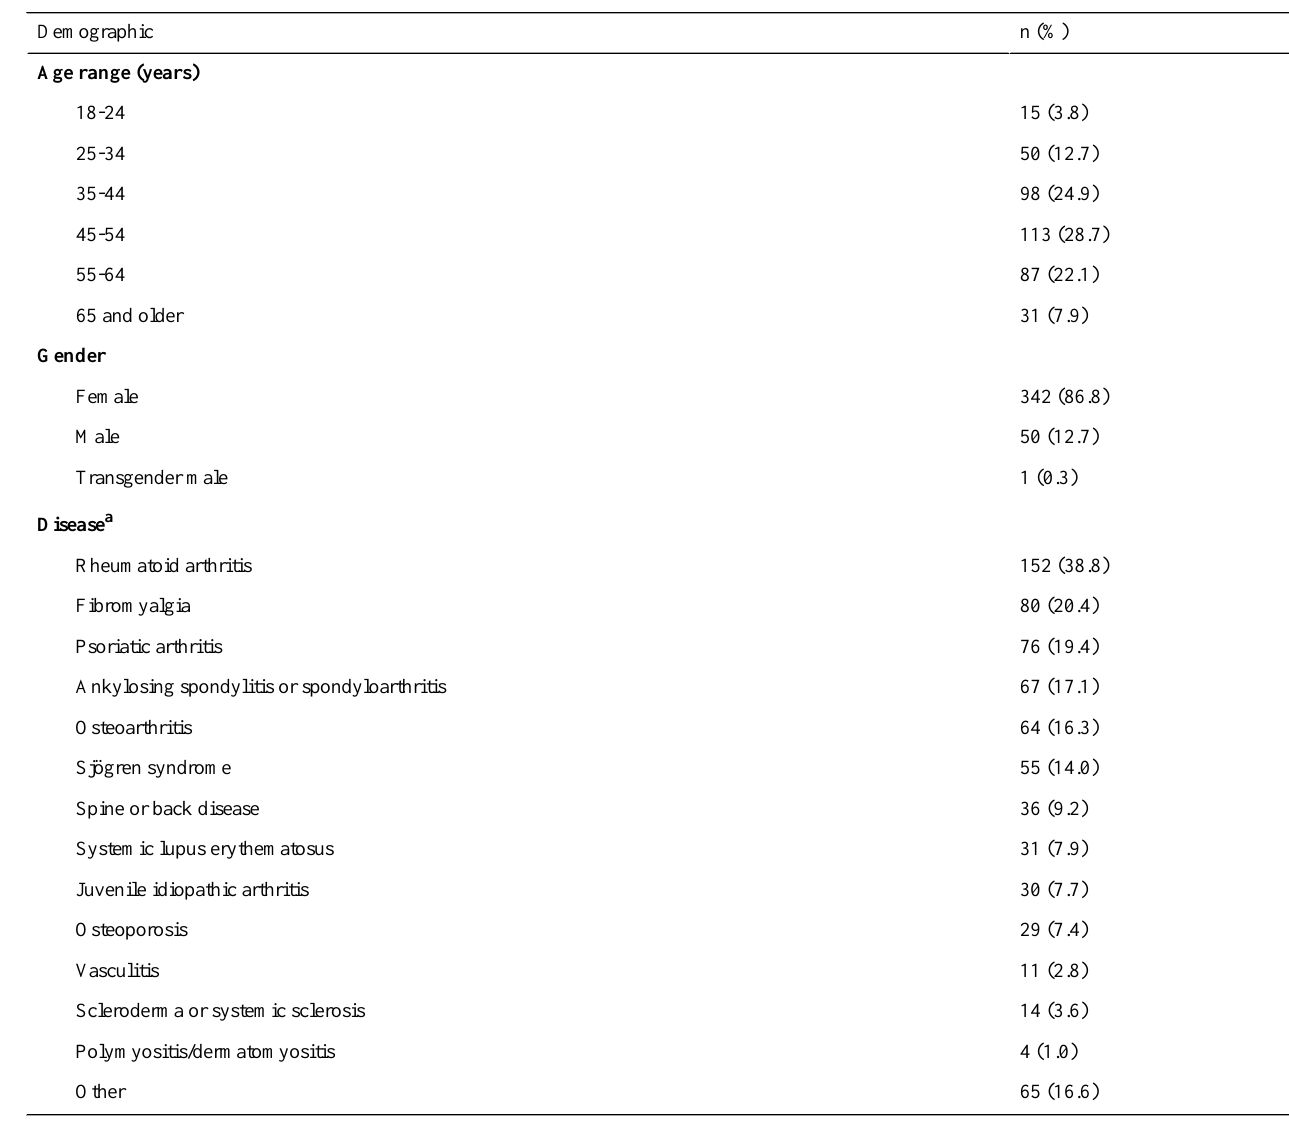
Table 1. Demographics and disease-related information of participants